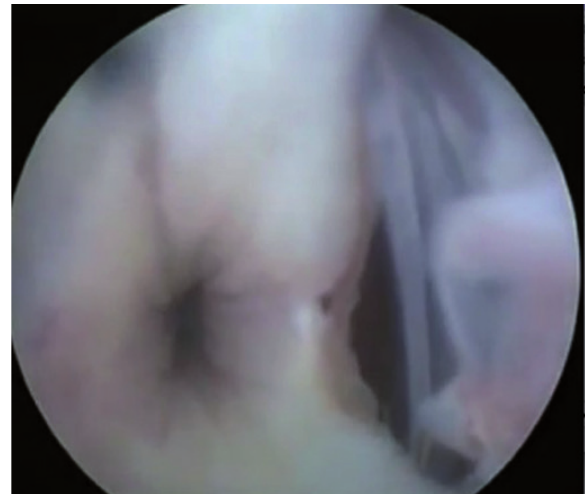
Figure 3 - urethral erosion of As. view from